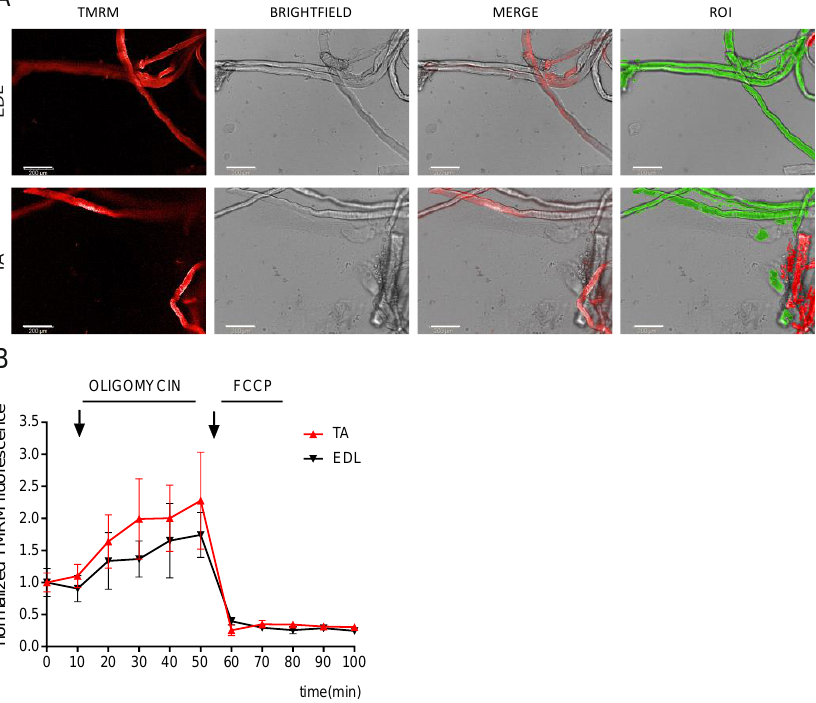
Figure 3. High-content microscopy of ΔΨm kinetics in isolated muscle fibers . ( A ) Fluorescent microscopy images of TMRM of muscle fibers isolated from extensor digitorum longus (EDL; top ) and tibialis anterior (TA; bottom) muscles . Intact, unblemished myofibers appear as translucent cylinders with striated patterns (as shown in the brightfield images). White scale bars: 200 µ m. ( B ) Mitochondrial membrane potential (TMRM fluorescence intensity) was quantified and analyzed in the selected individual myofibers. Values are normalized to basal intensity levels. Data represent mean ± SEM of 3 biological replicates.